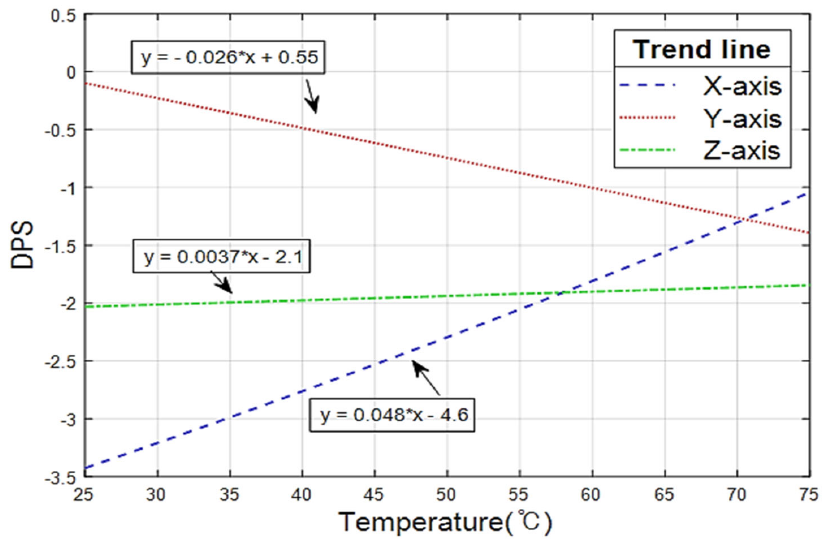
Figure 11. Trend line of the measured values by temperature in the X-, Y-, and Z-axes of the gyroscope sensor.